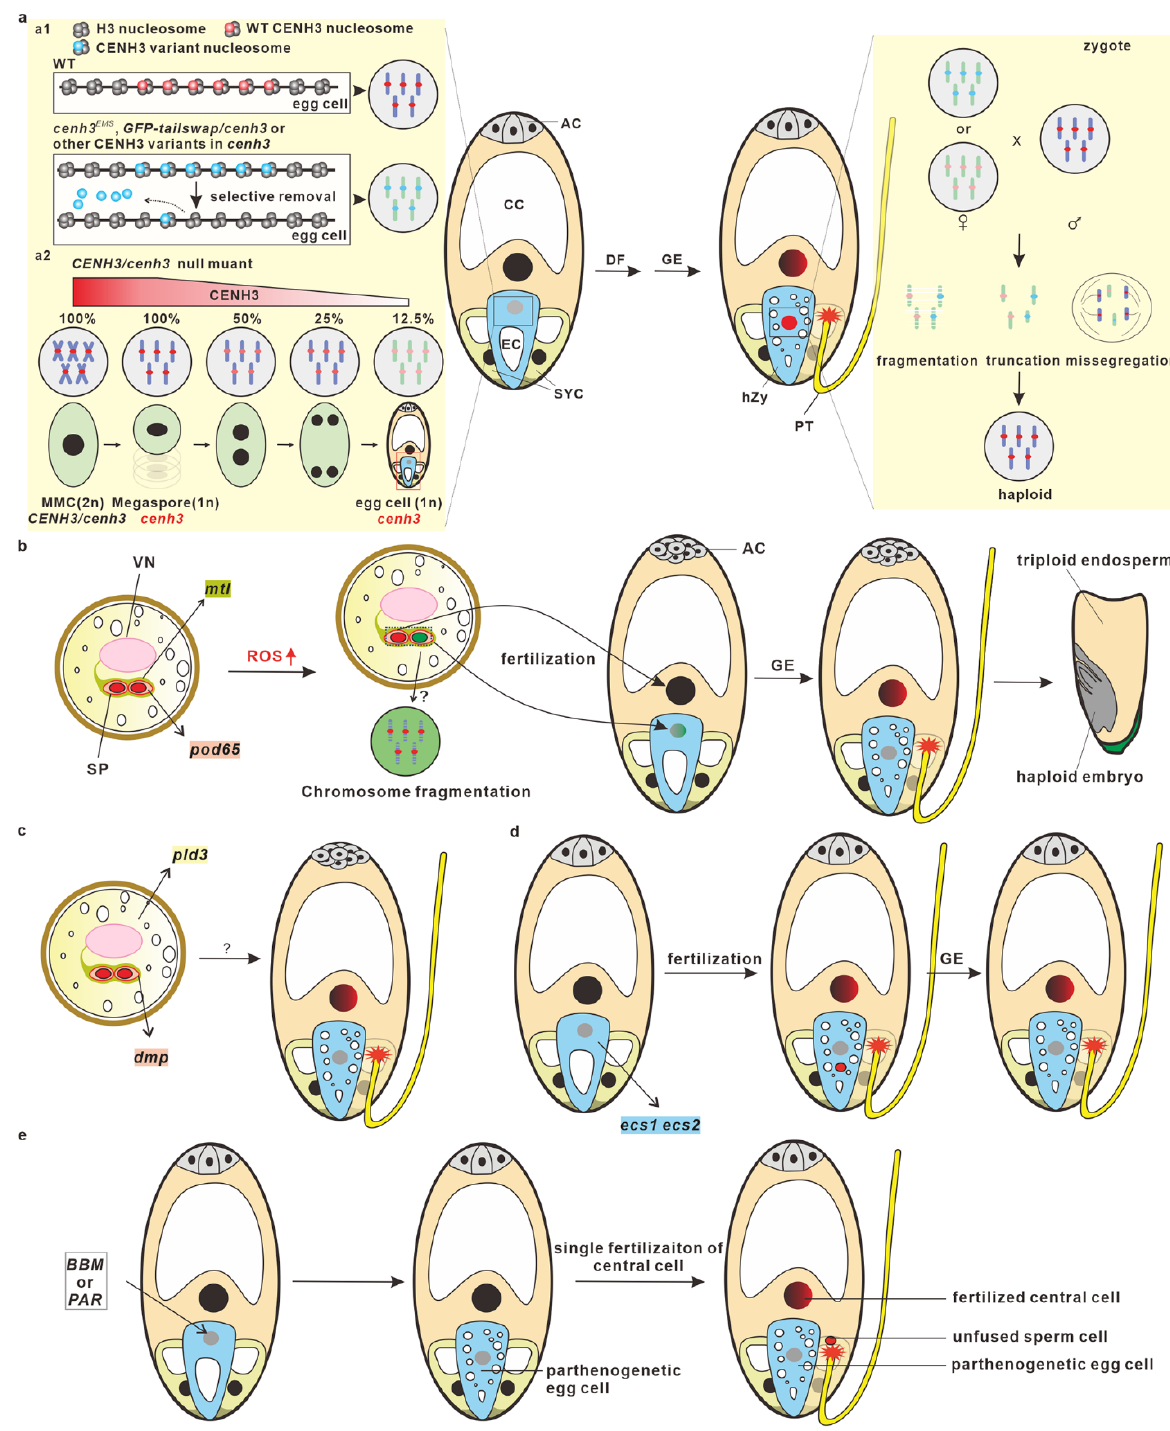
Figure 2. Model of in vivo haploid embryogenesis. ( a ) CENH3-mediated haploid embryogenesis is accomplished through post-fertilization genome elimination. This model shows CENH3-mediated maternal genome elimination after fertilization. In a cenh3 EMS mutant , the GFP-tailswap/cenh3 mutant or cenh3 mutants which express the CENH3 variant from other species, selectively eviction of CENH3 variants in mature egg cells and the zygotes produce “weak” centromeres ( a1 ). In a heterozygous model of a cenh3 null mutant, the quantity of CENH3 on the centromeres is significantly diluted after megasporogenesis, which also generates “weak” centromeres in cenh3 egg cells ( a2 ). After being pollinated by wild-type pollen grains, the maternal genome (gray), which contains “weak” centromeres, rather than the normal paternal g enome (red), is selectively eliminated in zy- gotes and early embryos. ( b ) Mutations in MTL and POD induces haploid embryogenesis through